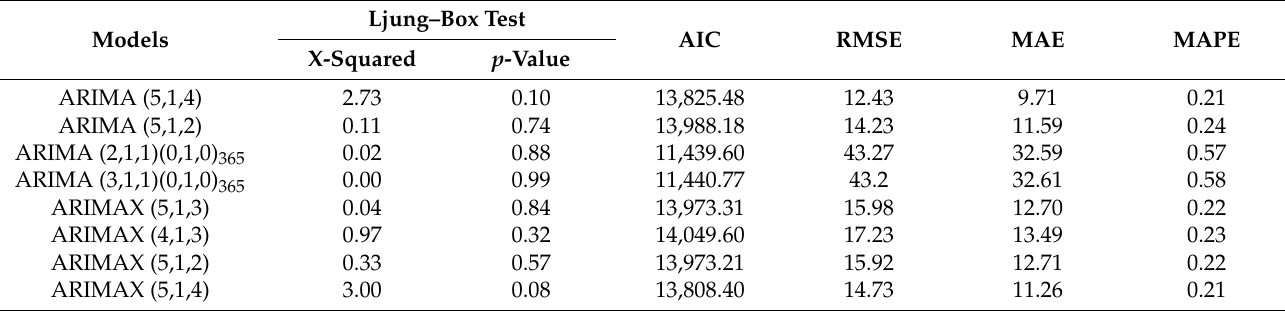
Table 3. Comparison of the ARIMA and ARIMAX